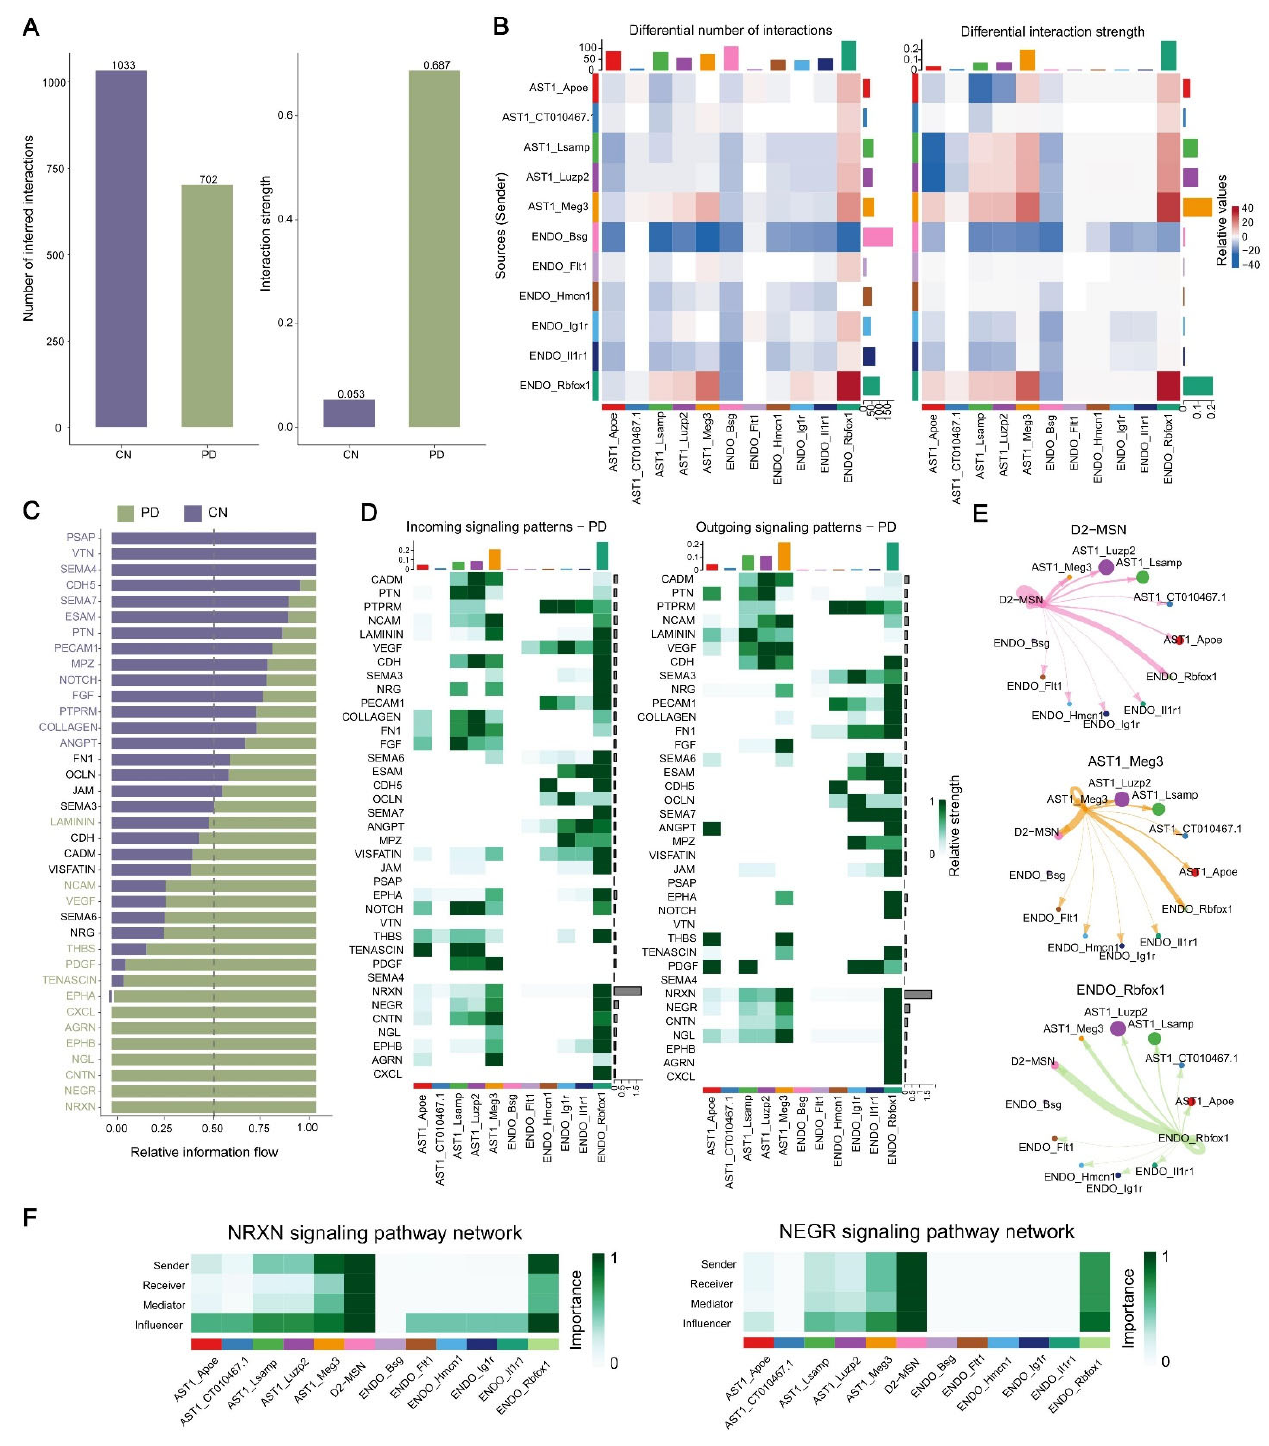
Figure 5. Characterization of cell communications among PD ‐ specific cells. ( A ) The number and strength of AST1 and ENDO intercellular ligand–receptor interactions in PD and CN. ( B ) Heatmaps of the interaction quantity (left) and strength (right) between AST1 and ENDO subpopulations in PD and CN. ( C ) Identification and visualization of conserved and specific signaling pathways. ( D ) Heatmaps of the outgoing and incoming signaling patterns of AST1 and ENDO subclusters in PD. ( E ) Circle plots show and compare cell–cell communication alterations among PD ‐ specific cells. ( F ) Heatmaps of the NRXN and NEGR signaling networks displaying relative importance of each cell group ranked.